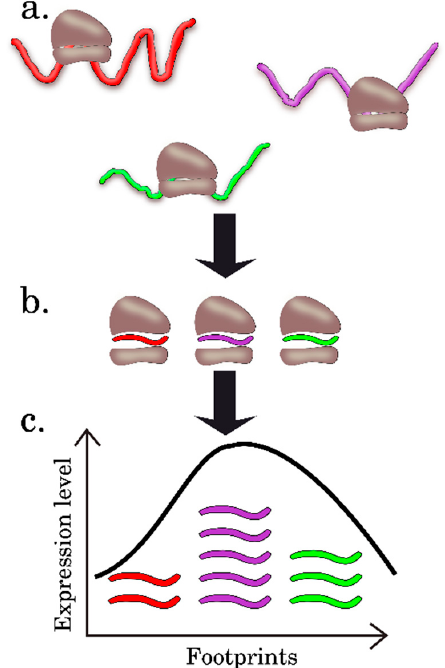
Figure 4. Principle of analysis, interpretation, and visualization of the ribosome profiling data. ( a ) The ribosomes arrested on transcripts ( b ) form ribosome footprints after RNase hydrolysis. ( c ) The footprints mapped onto genome can be associated with particular sequences to assess the relative amount and positions of ribosomes on the transcripts on a genome-wide scale.